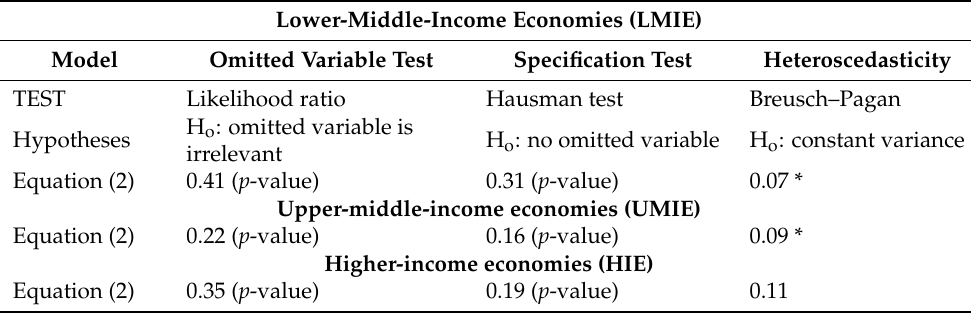
Table 17. Diagnostic checks for endogeneity and heterogeneity in the